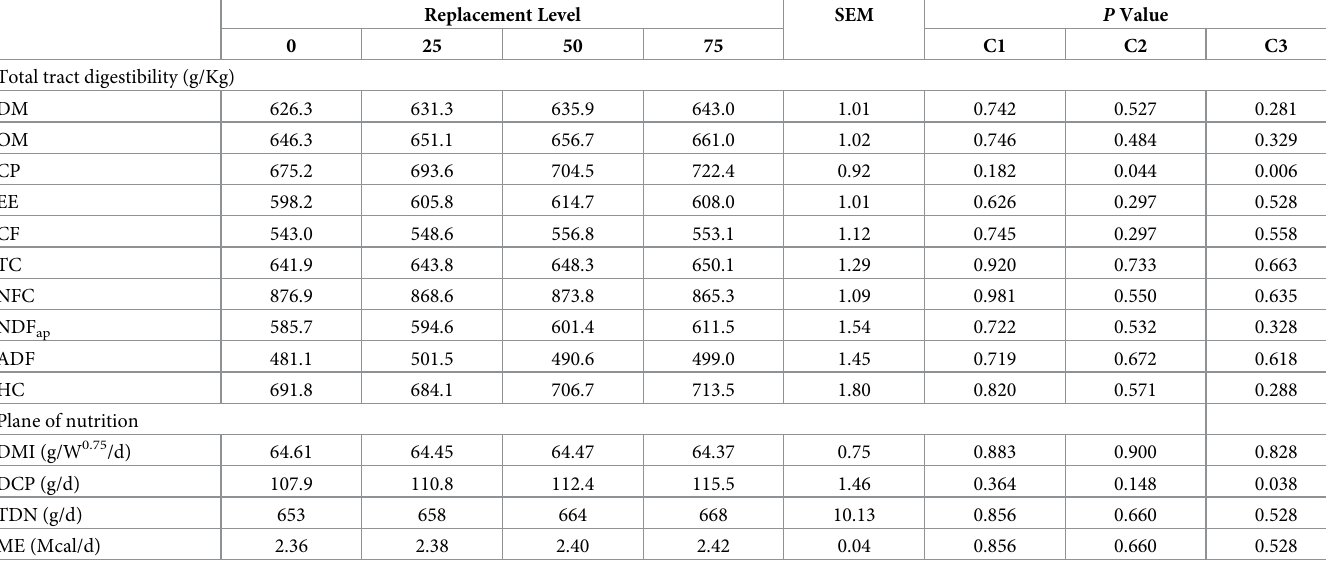
Table 3. Effect of replacing soybean meal with SRU on total tract digestibility and plane of nutrition of dietary constituents of adult